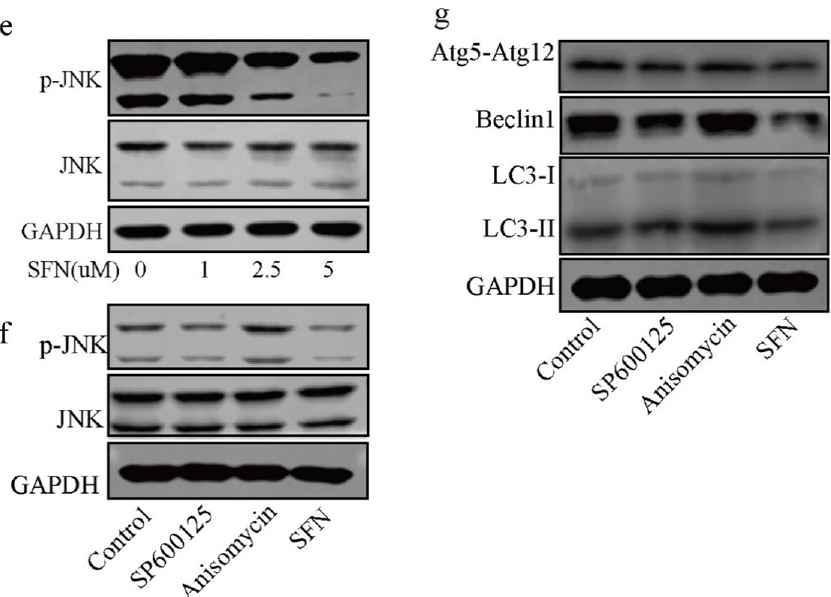
Figure 4. RAP reversed SFN-mediated anti-osteoclatogenic effects. Raw264.7 cells were cultured with 50 ng/mL of RANKL in the absence or presence of 2.5 µ M SFN and 10 µ M RAP for 5 days. ( a ) Representative images showing osteoclastogenesis in each group and corresponding statistics. ( b ) Representative images showing F-actin stained with phalloidin (red). DAPI (blue) was used to visualize the nuclei. ( c , d ) Representative qRT-PCR and WB results showing MMP9 and CTSK expression. To detect JNK signaling, RAW 264.7 cells were stimulated with SP600125. Anisomycin, or SFN for 2 h and then treated with 50 ng/mL of RANKL for 30 min. ( e ) WB results showing the activation level of JNK signaling after treatment with varying concentrations of SFN. ( f ) WB results showing the activation level of JNK signaling. To explore the role of JNK signaling in SFN-mediated inhibition of autophagy, we stimulated RAW 264.7 cells with SP600125, anisomycin, or SFN for 2 h and then treated them with 50 ng/mL of RANKL for 24 h. ( g ) WB results showing protein levels of autophagic molecules (Atg5, Atg12, Beclin1, and LC3). Values are mean ± SEM of three independent experiments; * p < 0.05, ** p < 0.01.